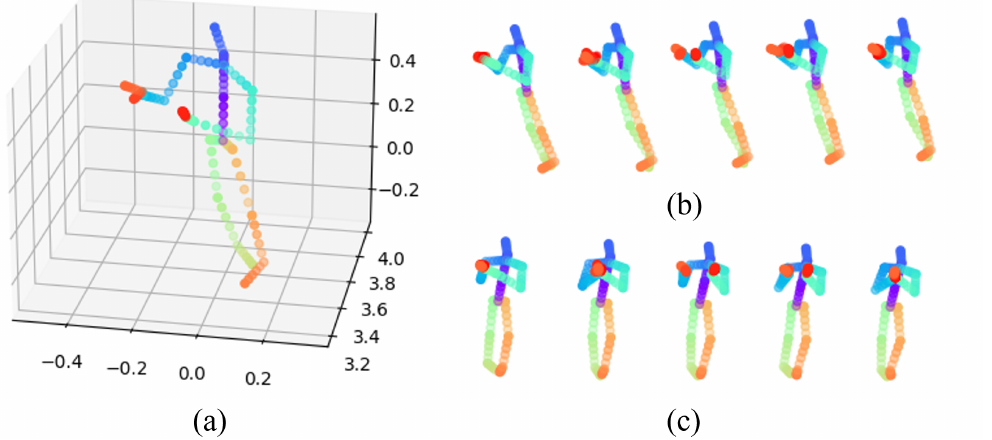
Figure 2. ( a ) Three-dimensional skeleton point cloud in a single frame, ( b ) frames of 3D skeleton point cloud before view adjusting, ( c ) frames of 3D skeleton point cloud after view